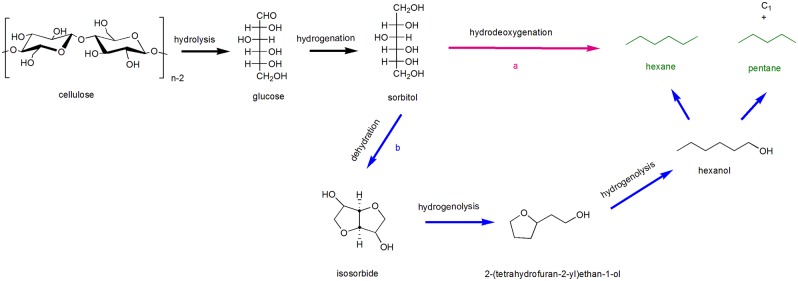
Probable pathway of cellulose conversion to pentane and hexane via sorbitol.